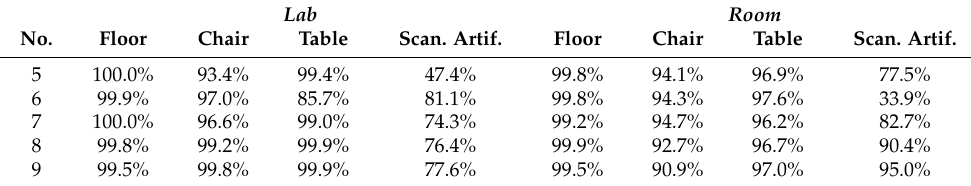
Table A3. Cont. Lab Room No. Chair Scan. Artif. Floor Chair Scan. Artif.